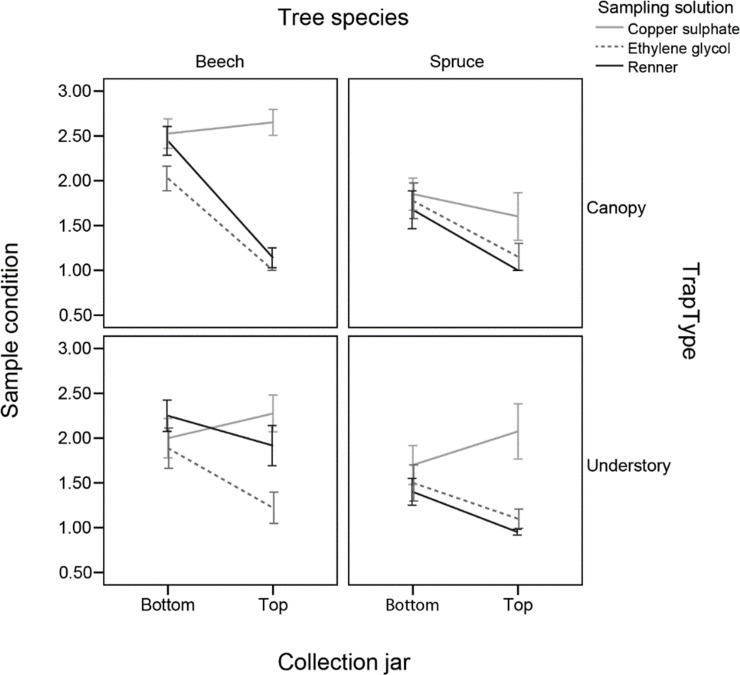
The condition of the samples across the different treatments.Higher values indicate worse condition. Error bars represent ±1SE.